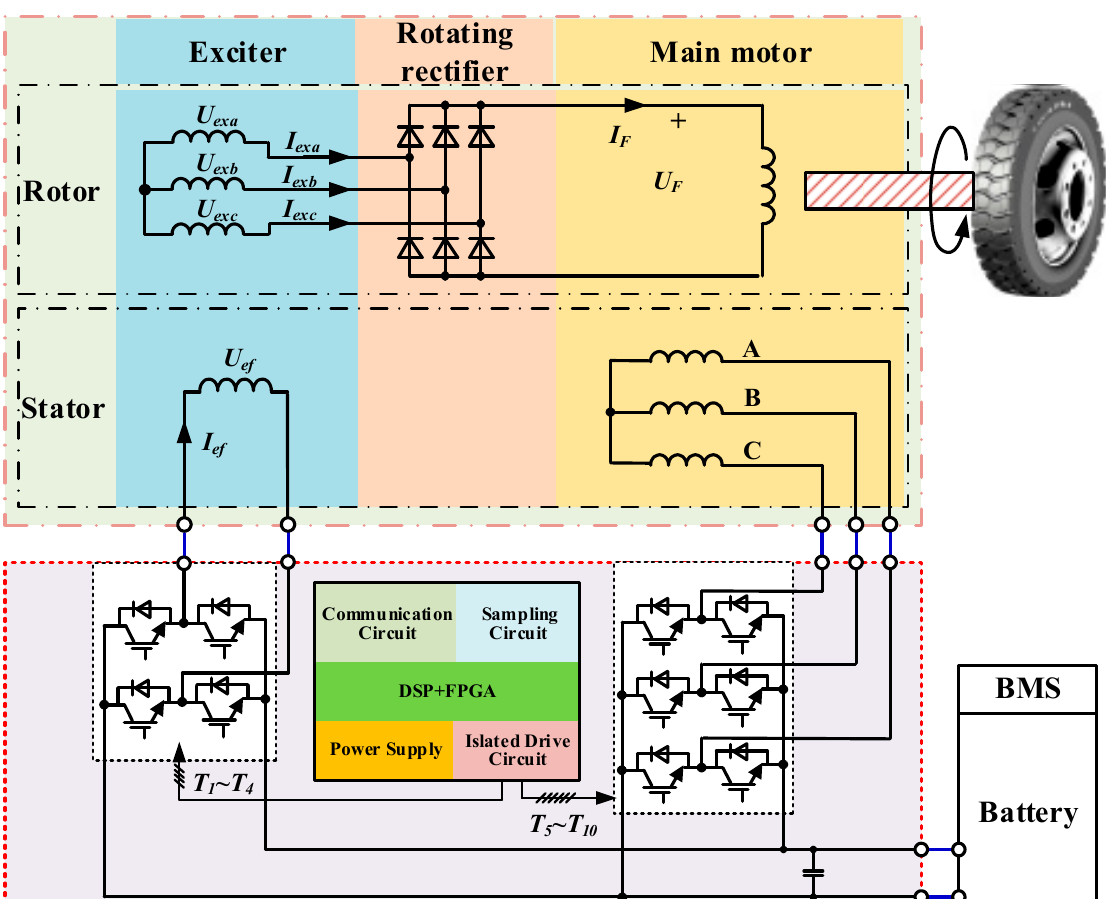
Figure 2. The con fi guration of the WFSM drive system.